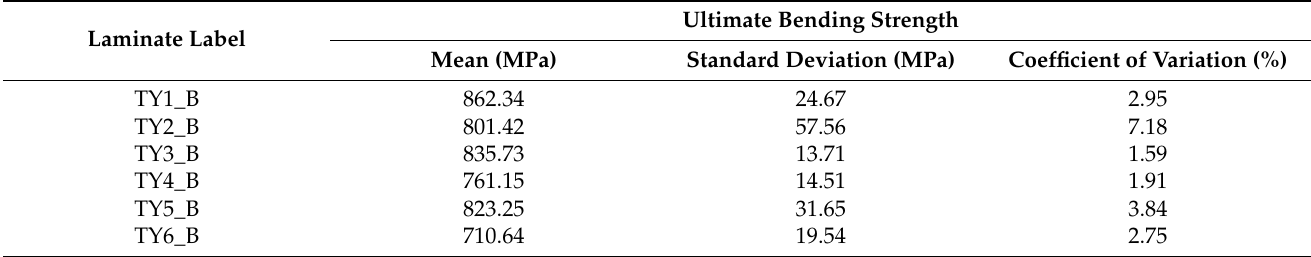
Table 5. Ultimate bending strength for different batches of